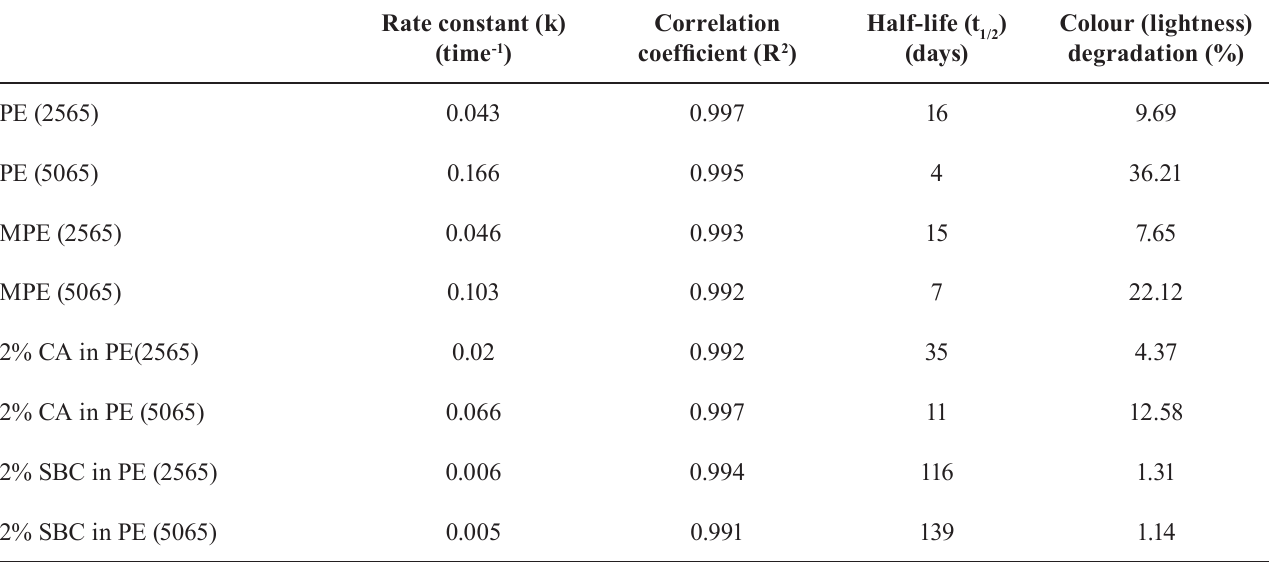
#PE: Polyethylene, MPE: Metalized polyethylene, CA: citric acid, SBC: sodium bicarbonate, 2565: 25°C and 65% relative humidity, 5065: 50°C and 65% relative humidity. #The values of rate constant, correlation coefficient and half life correspond to zero order kinetic fit model. Half-life (t½), the time required for the rice:Spirulina blend to decrease to 50% of its initial colour was calculated from the rate constant as